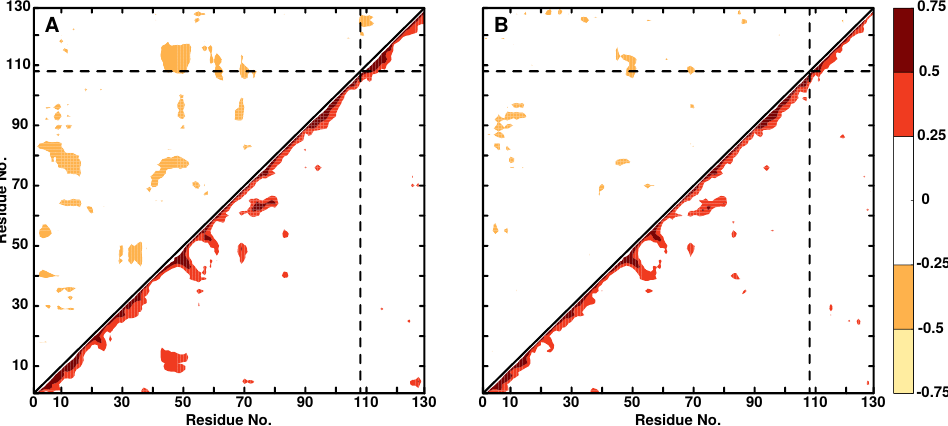
Figure 3. DCCM for WT lysozyme (panel A ) and Ala108N 3 (panel B ). Positive correlations are in the lower right triangle, negative correlations in the upper left triangle. Only correlation coefficients with an absolute value greater than 0.25 are